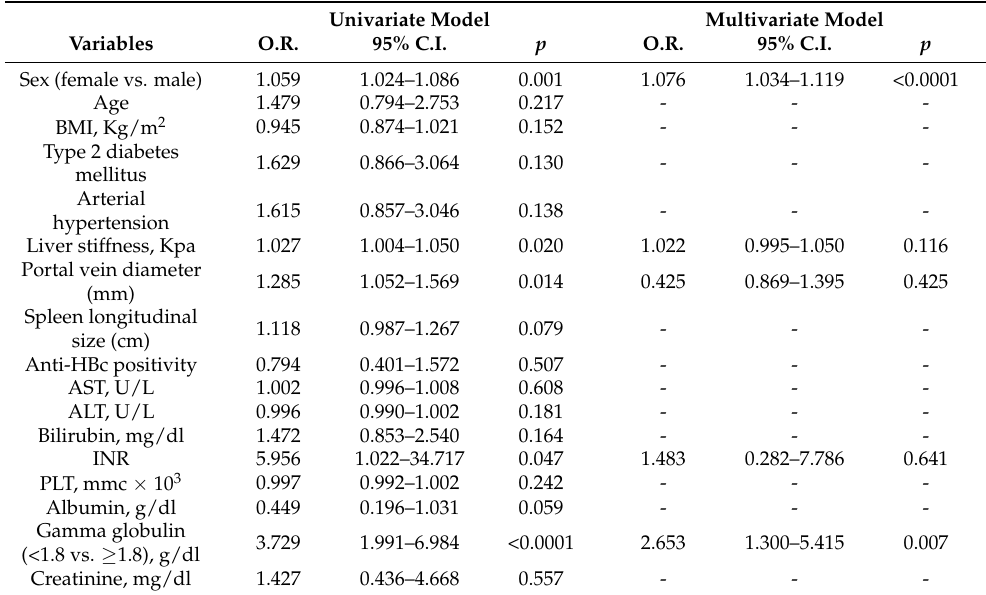
Table 5. Univariate and multivariate logistic regression analyses of different predictors variables of death. Univariate Model Multivariate Model Variables O.R. 95%